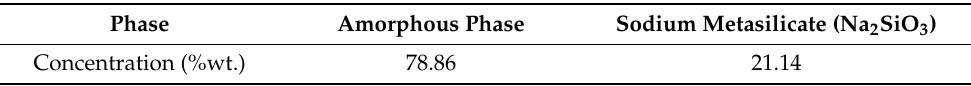
Table 5. Phase analysis of dry activator synthesized with NaOH and geothermal silica with a ratio of 1:1 (wt./wt.) and calcined at 400 °C.